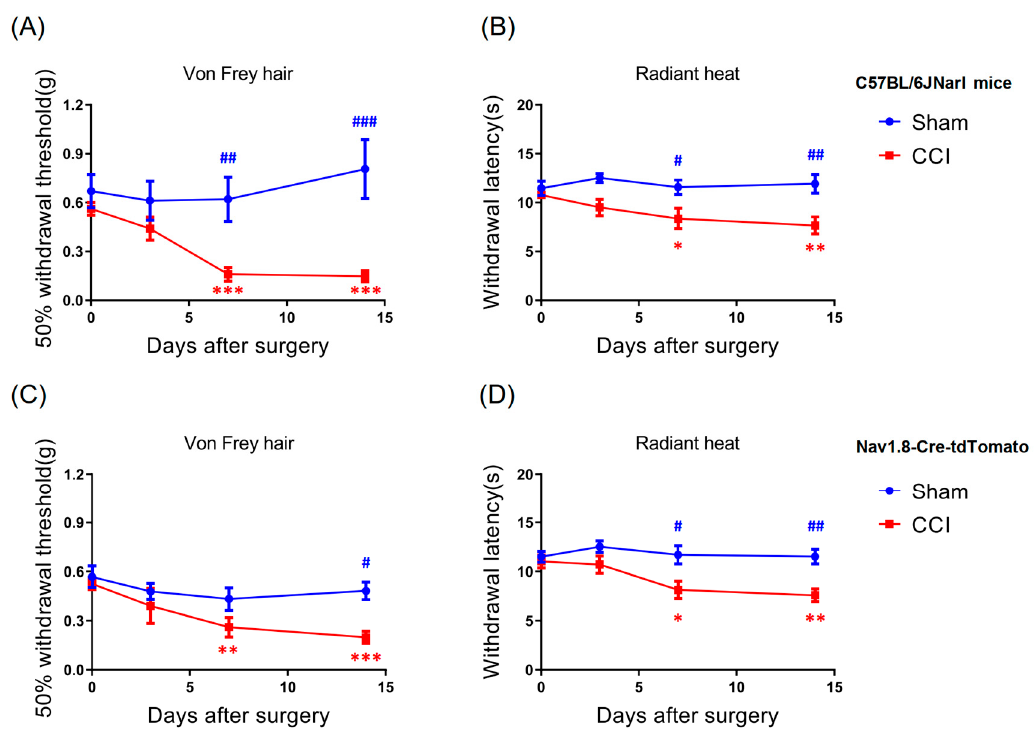
Figure 2. Effects of CCI-induced behavioral changes in wild-type mice and Nav1.8-tdTomato mice. ( A,B ) Both wild type (WT) and ( C,D ) Nav1.8-tdTomato mice developed mechanical hypersensitivity and thermal hyperalgesia after CCI surgery (WT-sham, n = 7; WT-CCI, n = 12; Nav-sham, n = 8; Nav-CCI, n = 15). * p < 0.05, ** p < 0.01 and *** p < 0.001, compared with the baseline of the CCI group; # p < 0.05, ## p < 0.01 and ### p < 0.001, compared with sham groups.